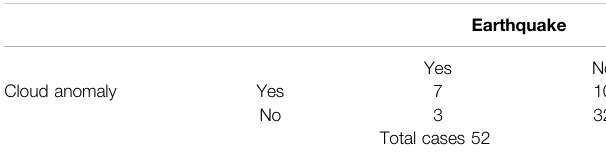
TABLE 3 | Error matrix for the statistical evaluation of the cloud anomalies 23 – 45 days before the M ≥ 4.7 earthquakes in Italy during 2010 – 2013.